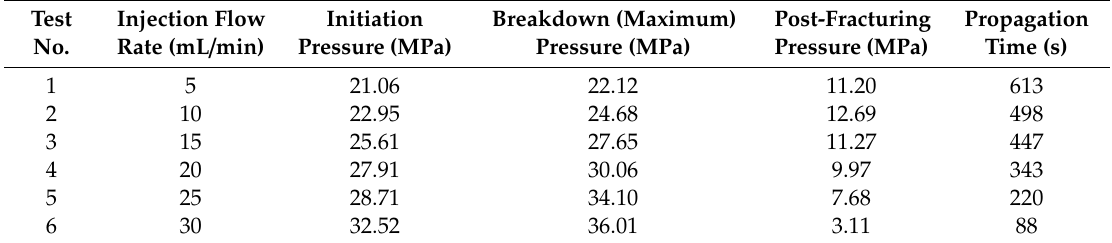
Table 3. Fracturing experimental parameters and